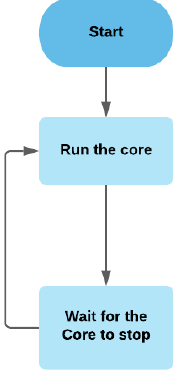
Figure 12. The flowchart of the launcher module.